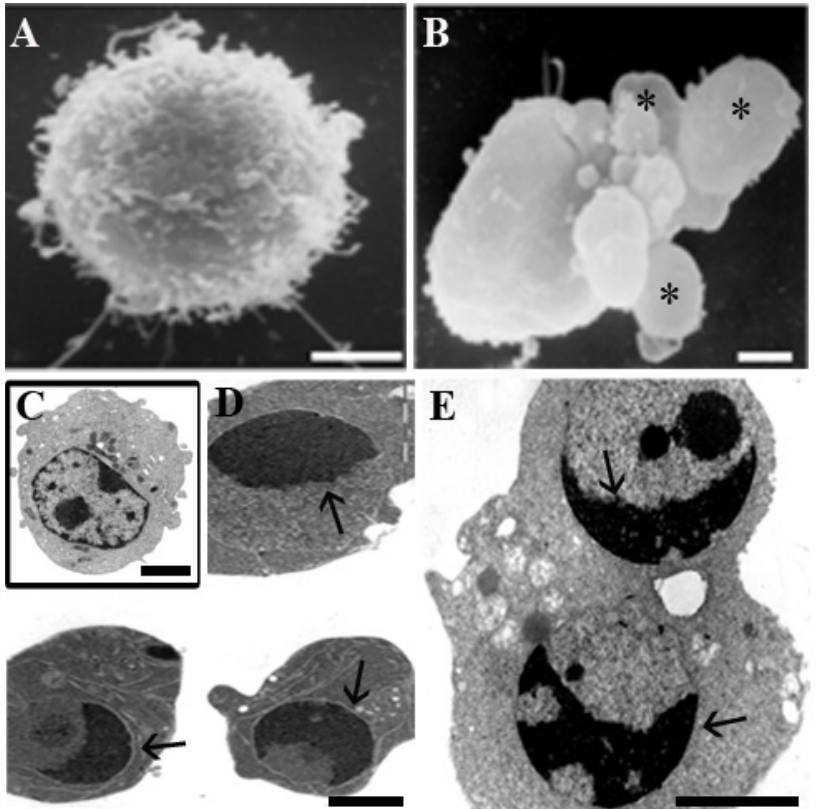
Figure 1. Control ( A ) and Ultraviolet B (UVB)-treated ( B ) HL-60 cells at Scanning Electron Microscopy (SEM). Surface blebbing ( B , asterisks), absent in the control ( A ), appears. Control ( C ) vs . treated U937 ( D ) cells and treated Molt-4 ( E ) cells at Transmission Electron Microscopy (TEM). Condensed chromatin, organized in cup-shaped masses (arrows) under the nuclear envelope, can be observed in both cases ( D , E ). Scale bars: A – C , 2 µm; D,E, 1